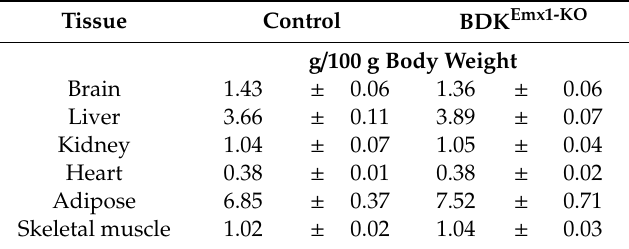
Comparison of weights of tissues relative to the body weight (g / 100 g) for the control and BDK Emx1-KO mice.